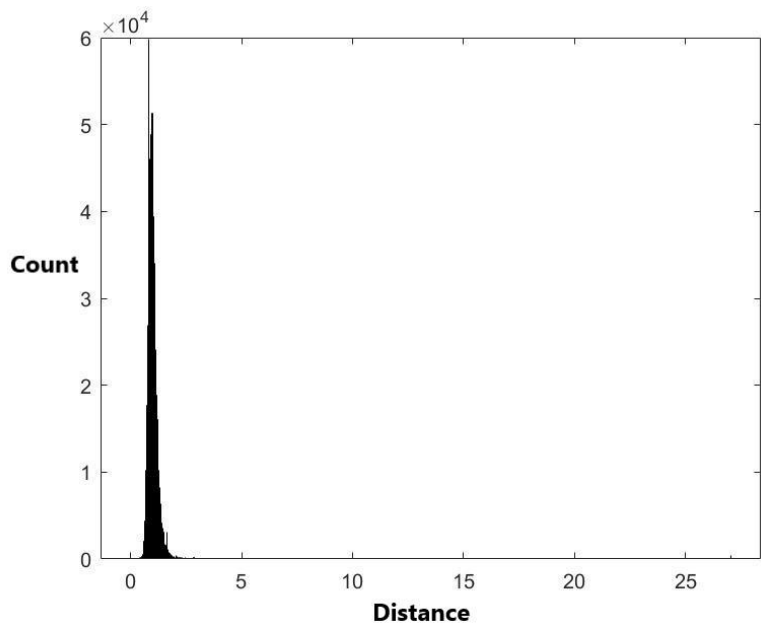
Figure 1. The histogram of the 1,836,486 distance data.